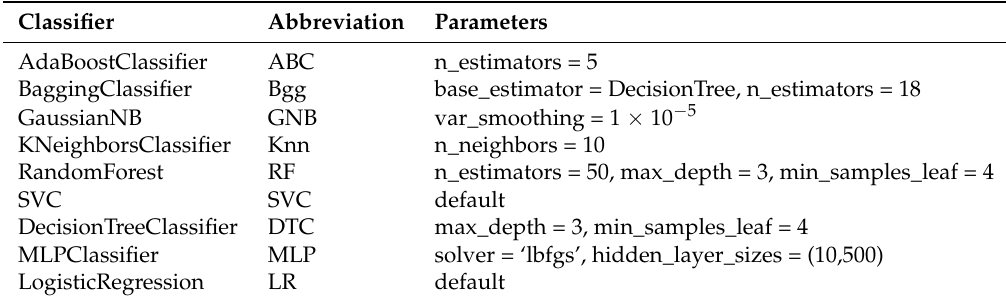
Results: Table 4 summarize the results of nine classifiers on 29 datasets. The best result is highlighted with bold-face type. The differences between results of each classifier are analyzed by using Friedman and Wilcoxon statistical test